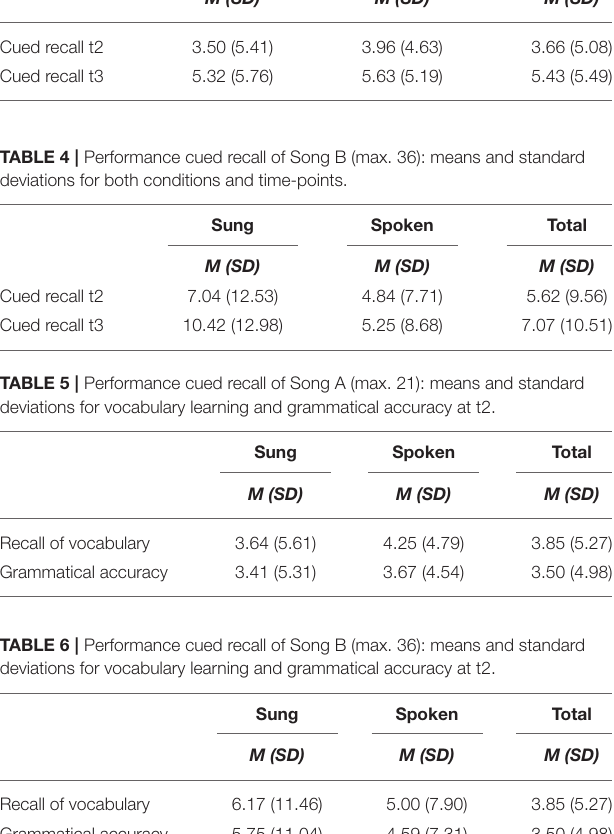
TABLE 2 | Performance language knowledge test (max. 32): means and standard deviations for both groups at the three time points. Group A*